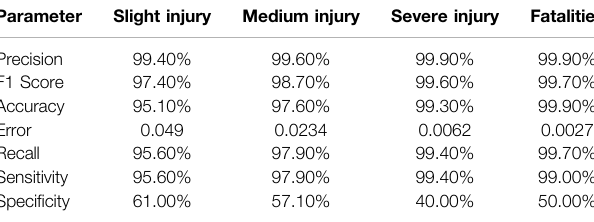
TABLE 3 | Percentages of parameters in the result of